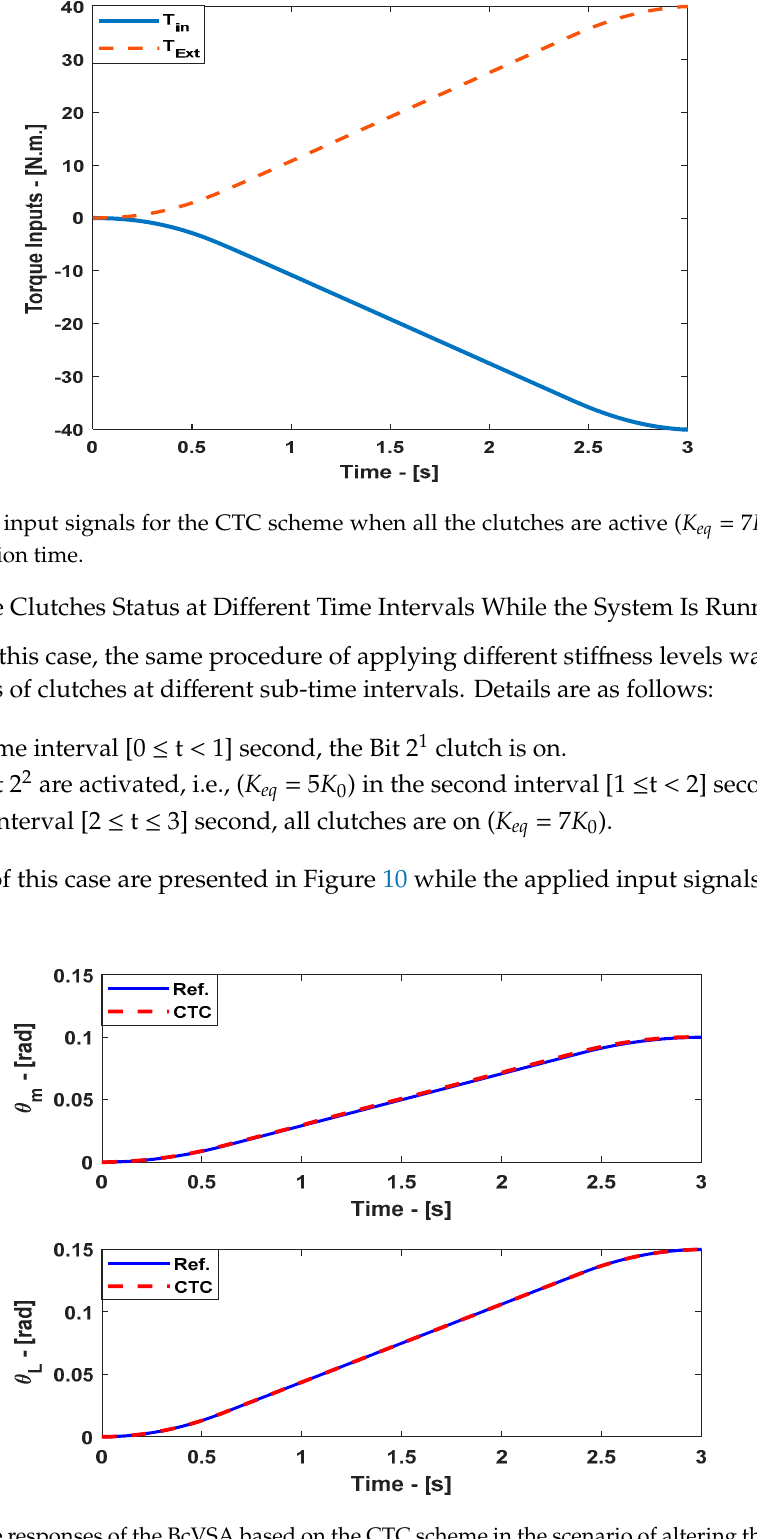
Figure 8. The responses of BcVSA by using the computed torque control (CTC) scheme under the condition when all the clutches are active ( 𝐾 (cid:3032)(cid:3044) = 7 𝐾 (cid:2868) ) for the entire simulation time. ( Top ) the input trajectory response; ( Bottom ) the output response.